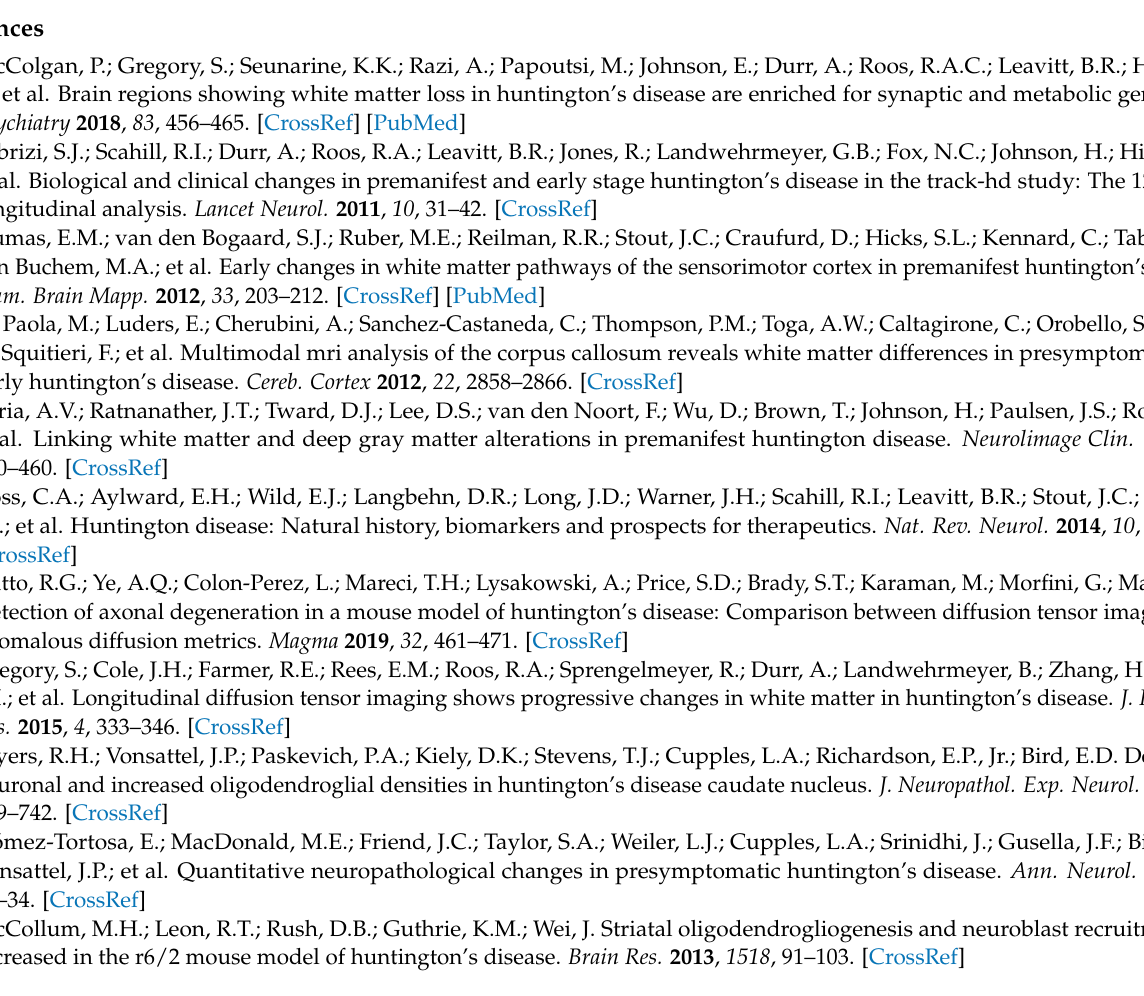
Figure S2: AAV9-OCT4 transduction in subventricular zone and corpus callosum, Figure S3: